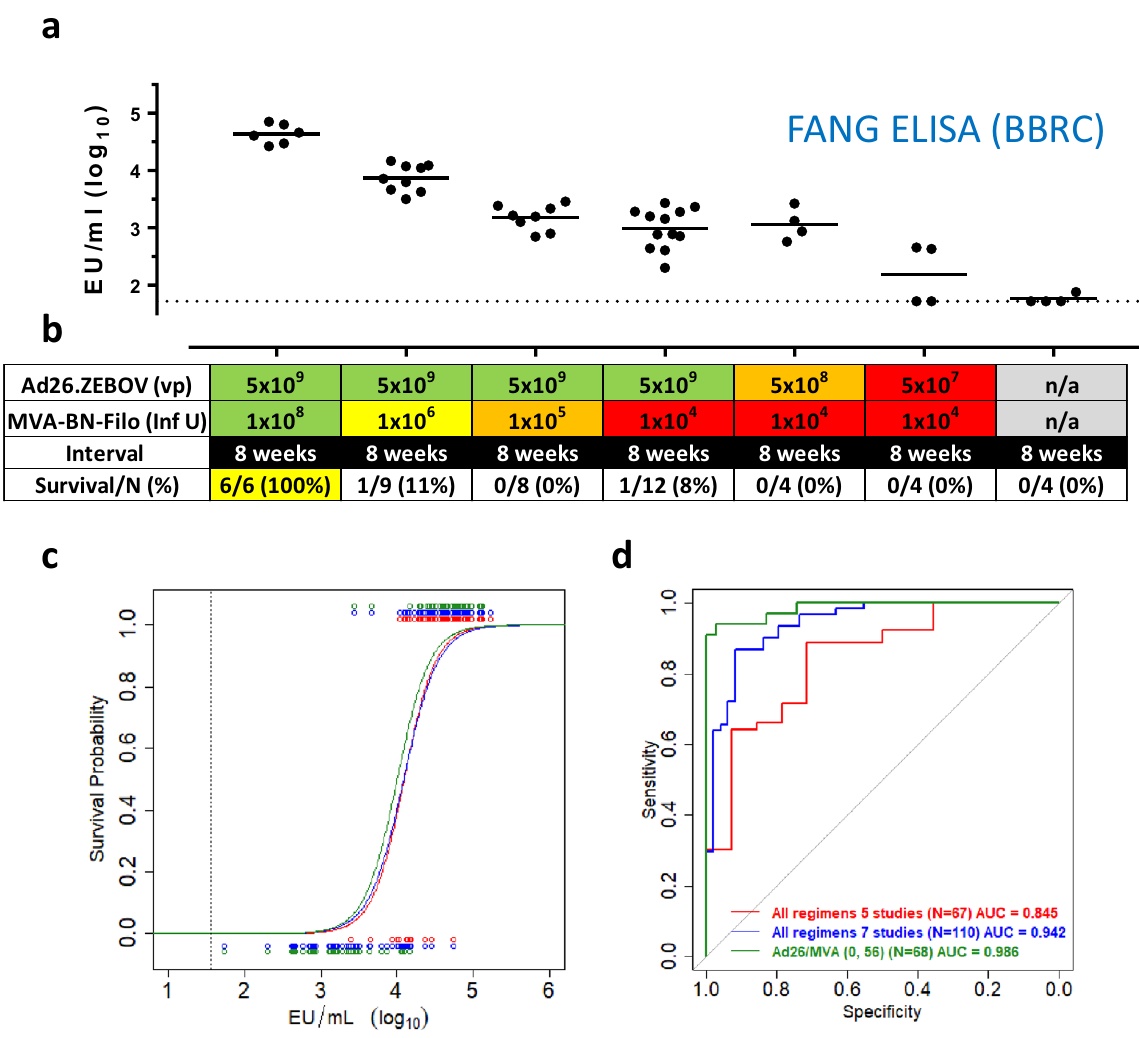
Fig. 4 Vaccine dose-down studies re fi ne logistic model based on GP-binding antibody levels for immunobridging. a EBOV GP-binding antibody concentrations (EU/mL, log 10 transformed) as determined by FANG ELISA (BBRC); group means are indicated; dotted line is LOD. b Table identi fi es dose of Ad26.ZEBOV and MVA-BN-Filo with highest dose represented in green and lowest dose in red. Vaccine dose interval is 8 weeks. An overview by regimen can be found in Supplementary Table 4. c Logistic regression models of GP-binding antibodies as predictor of survival after EBOV Kikwit challenge (100 pfu, IM) in NHP for all vaccine regimens combined from fi ve NHP studies (red), all regimens combined from seven NHP studies (blue), Ad26.ZEBOV, MVA-BN-Filo regimen with an 8-week interval only (green). Individual immune response levels are identi fi ed with open circles and the associated survival as a binary variable with survival as 1 (top) and nonsurvival as 0 (bottom). Assay LOD is indicated by dotted line. d ROC curves for sensitivity and speci fi city of GP-binding antibody levels in predicting NHP survival after challenge for all vaccine regimens combined from fi ve NHP studies (red), all regimens combined from seven NHP studies (blue), Ad26.ZEBOV, MVA-BN-Filo regimen with an 8-week interval only (green). ROC AUC are indicated in the panel. BBRC Battelle Biomedical Research Institute, ELISA enzyme-linked immunosorbent assay, EU ELISA units, FANG Filovirus Animal Non-Clinical Group, InfU infectious units, vp viral MVA-BN-Filo with an 8-week interval also for the fi rst time permitted the construction of a logistic model based on a single regimen